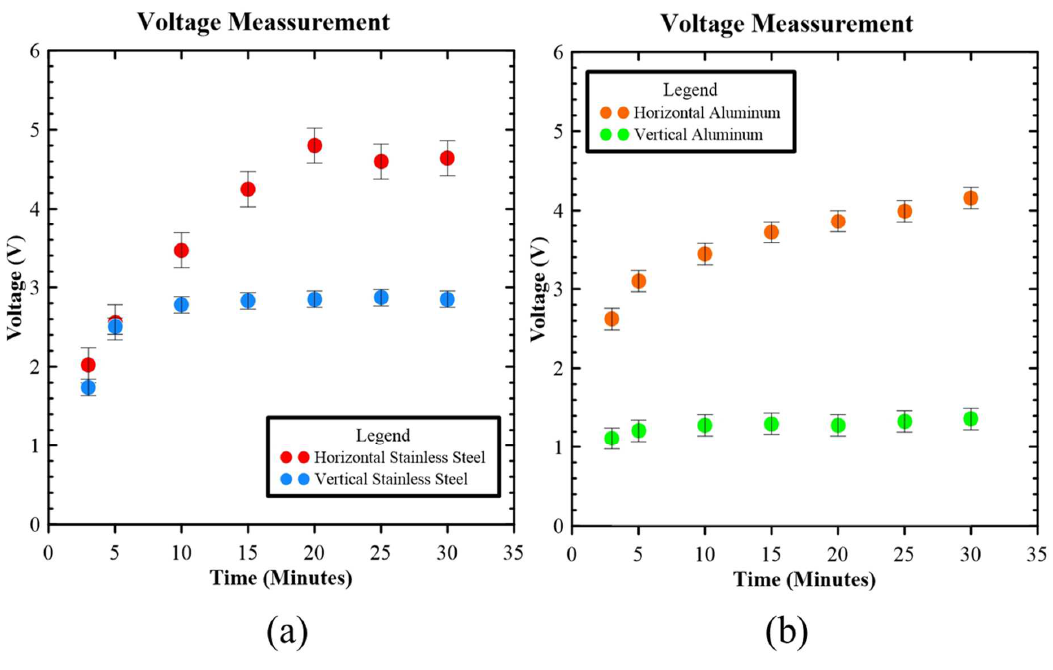
Figure 18. Voltage measurement for ( a ) stainless steel and ( b ) aluminum combustors. According to temperature and voltage measurements, the stainless steel horizontal vortex combustor had the highest measurement point, which would maximize the energy output of the stainless-steel horizontal vortex combustor. To maximize the electric energy output from the meso-scale vortex combustor, we also used two TEGs to measure the voltage energy output of the stainless-steel horizontal combustor. Figure 19. shows the voltage output measurement for two TEGs with series and parallel circuits. According to the results, the double TEGs with a water-cooled system had the highest voltage output.